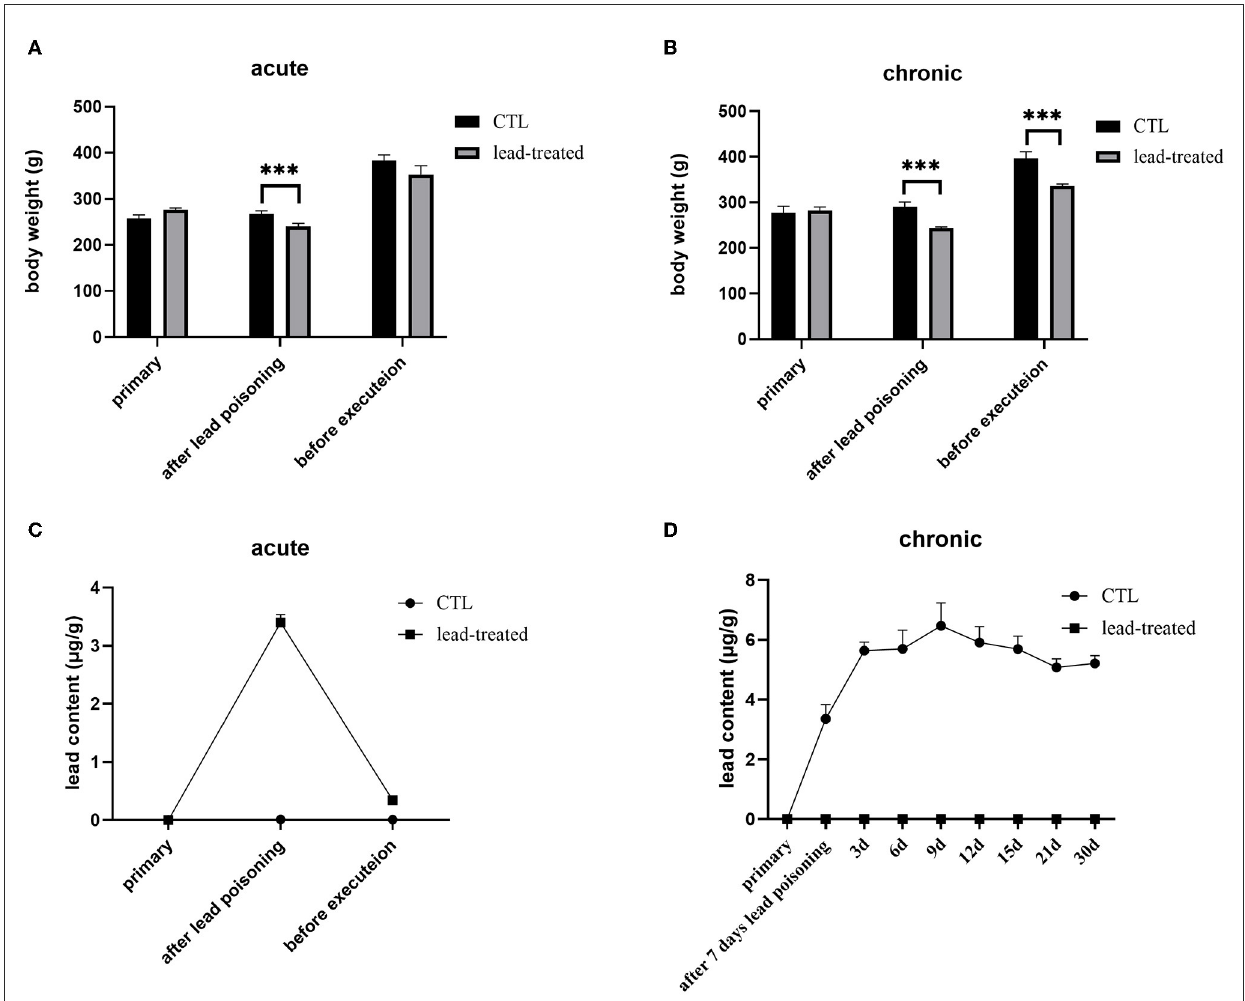
FIGURE3 Acute and chronic lead-induced poisoning rat models. (A, B) were the bodyweight of rats subject to acute or chronic poisoning, respectively; (C, D) were the lead content in the blood of the rats subject to acute or chronic poisoning. All values are represented as mean ± SD ( n = 6). *** P < 0.001 vs. CTL group as revealed by